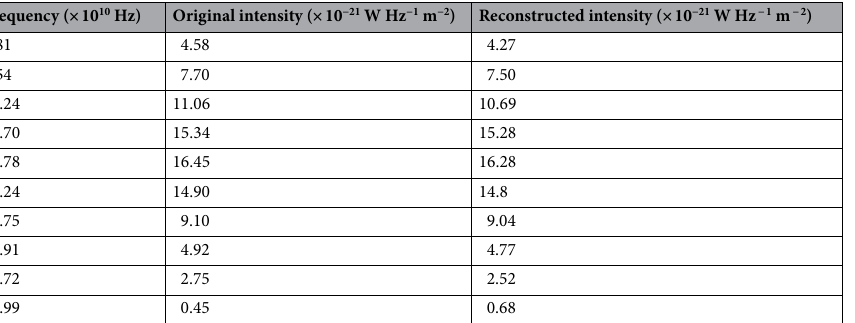
Table 4. All the values of original and reconstructed intensities for dipole are listed.